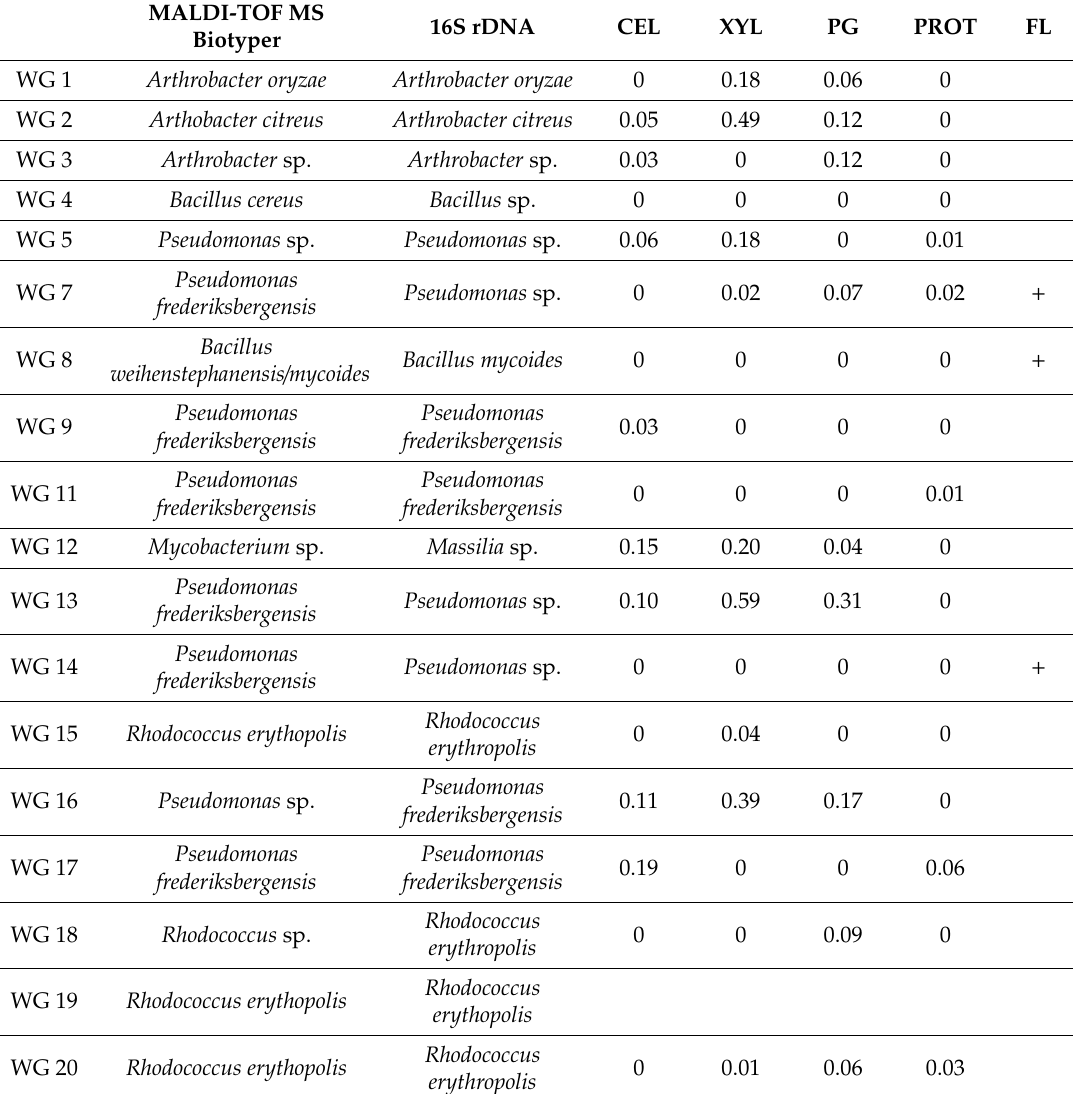
Table 1. Identification results of isolates with corresponding enzymatic activities (maximum values given, U / mL) and occurrence of